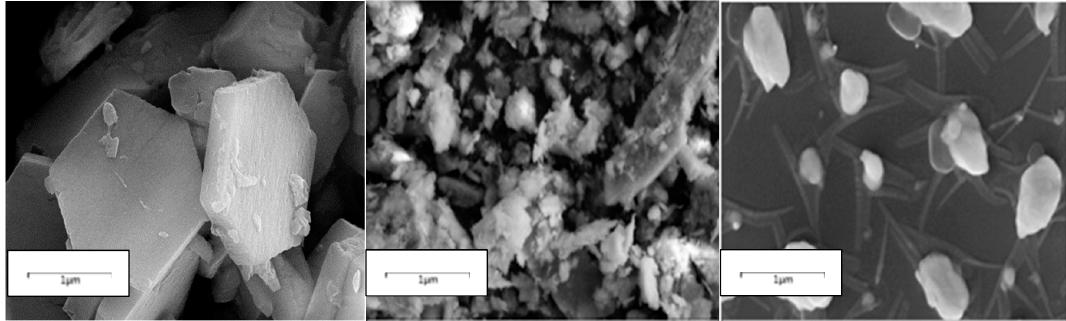
Figure 6. SEM analysis. SEM surface images of the bioflocculant ( left ), flocculated kaolin particles ( middle ) and kaolin particles ( right ).